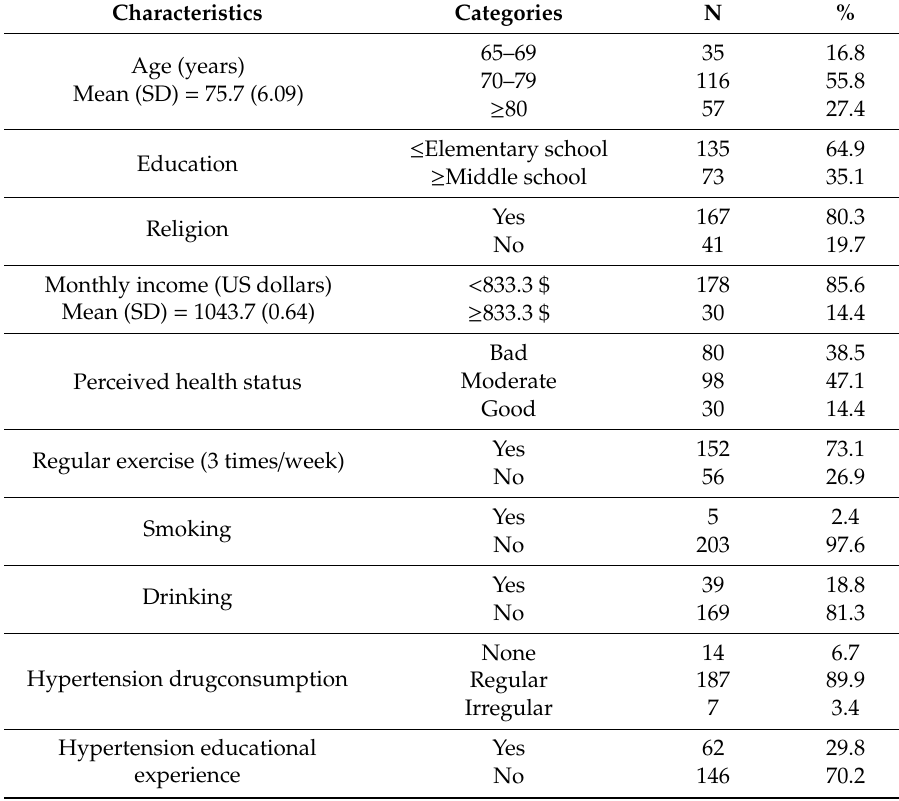
Table 1. Sociodemographic and health-related characteristics of participants (N =